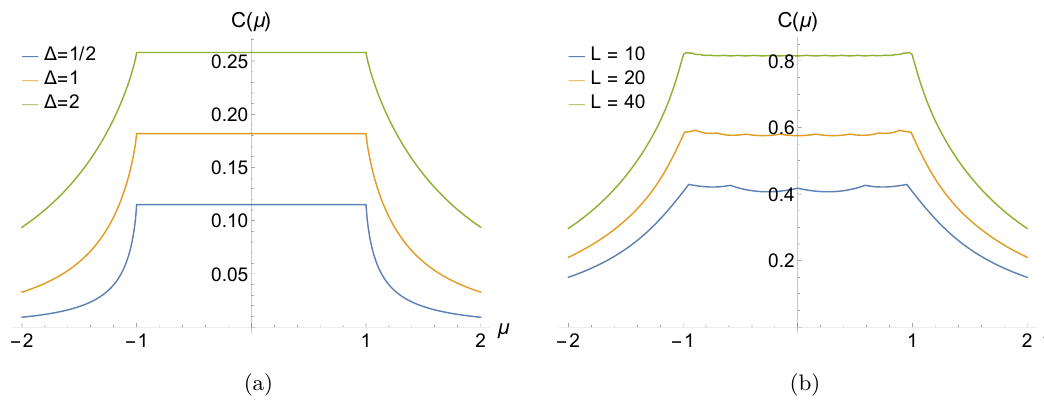
Figure 2 . a) The spread complexity for the circuit connecting the free fermion ground state and Kitaev chain ground state as a function of the chemical potential, with J = 1 , and in the continuum limit. The complexity is constant in the region | µ | < 1 . b) The spread complexity for the circuit connecting the free fermion ground state and Kitaev chain ground state as a function of the chemical potential, with J = 1 and ∆ = 2 . The spread complexity has been divided by purposes. The top curve corresponds to L = 40 , the middle L = 20 and the bottom L = 10